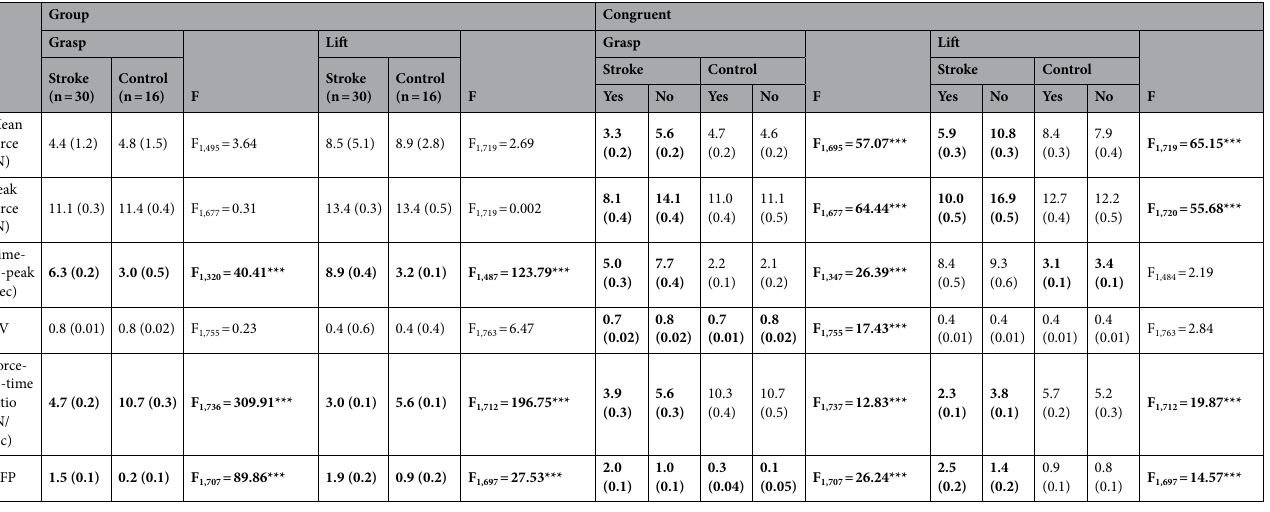
Table 1. Mean values of force variables: group and lateralization effects. Summary of the results. Group: lists the mean values (SE); Congruent: lists the mean values (SE), Yes—the examined hand was the dominant one; No—the examined hand was the non-dominant one. Bolded values denote a significant difference between the groups. Asterisks denote the p value: * p < 0.05, ** p < 0.01, *** p < 0.001. N Newtons, sec Seconds, CV Coefficient of variance, NFP Number of force